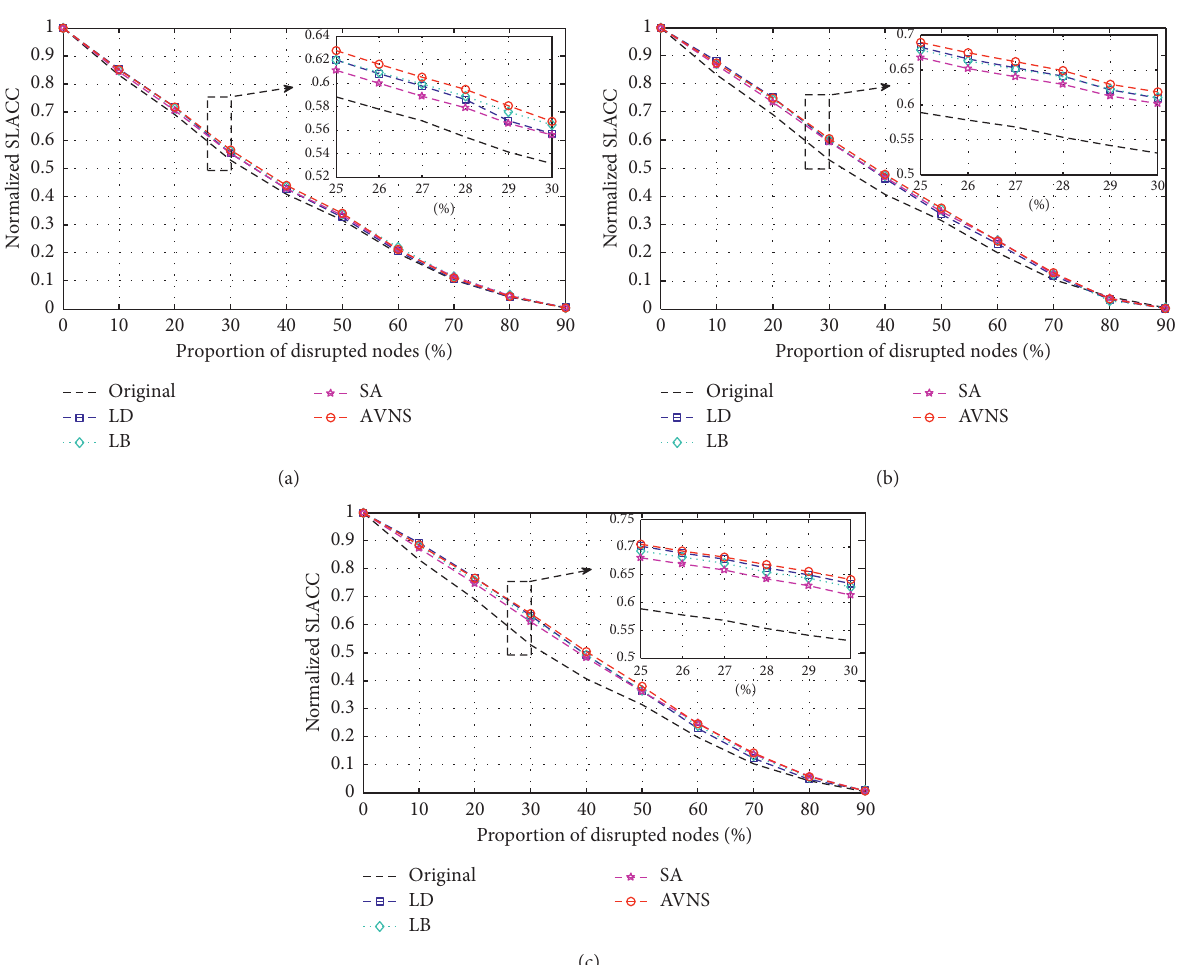
� 5%. (b) f � 10%. (c) f � 15%. a a a